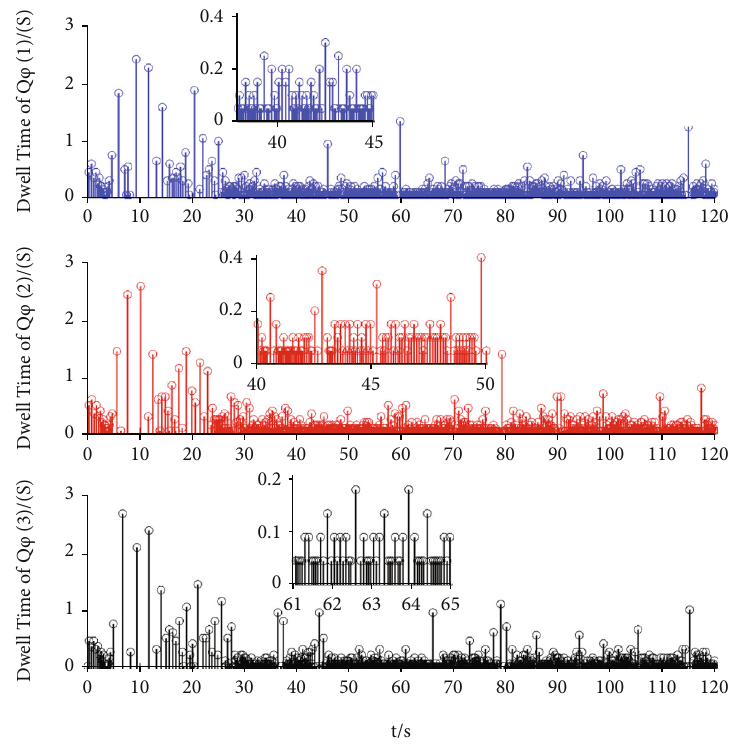
Figure 24: The dwell time of control torque.